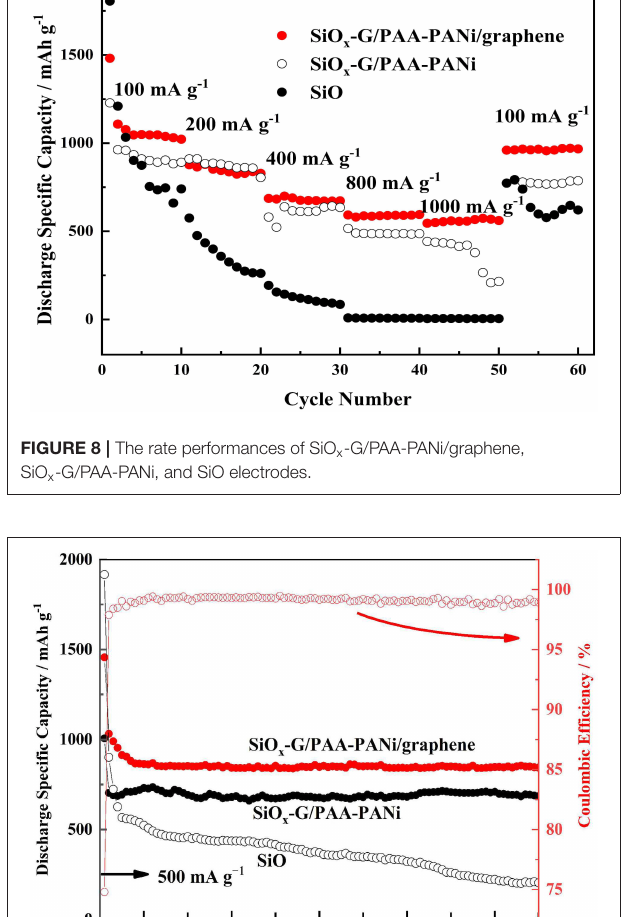
Figure 9 indicates the cycling stability of SiO x